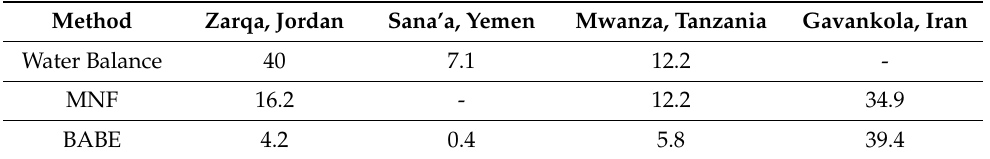
Table 8. Leak method